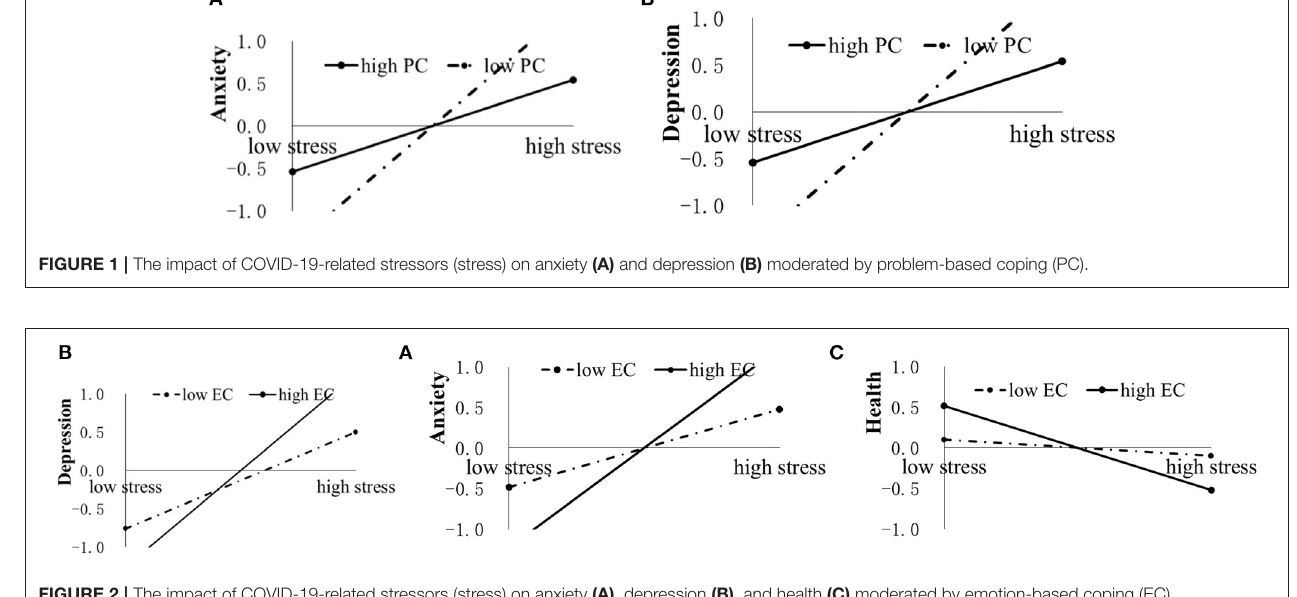
FIGURE 2 | The impact of COVID-19-related stressors (stress) on anxiety (A) , depression (B) , and health (C) moderated by emotion-based coping (EC). Note: Health = perceived general health.